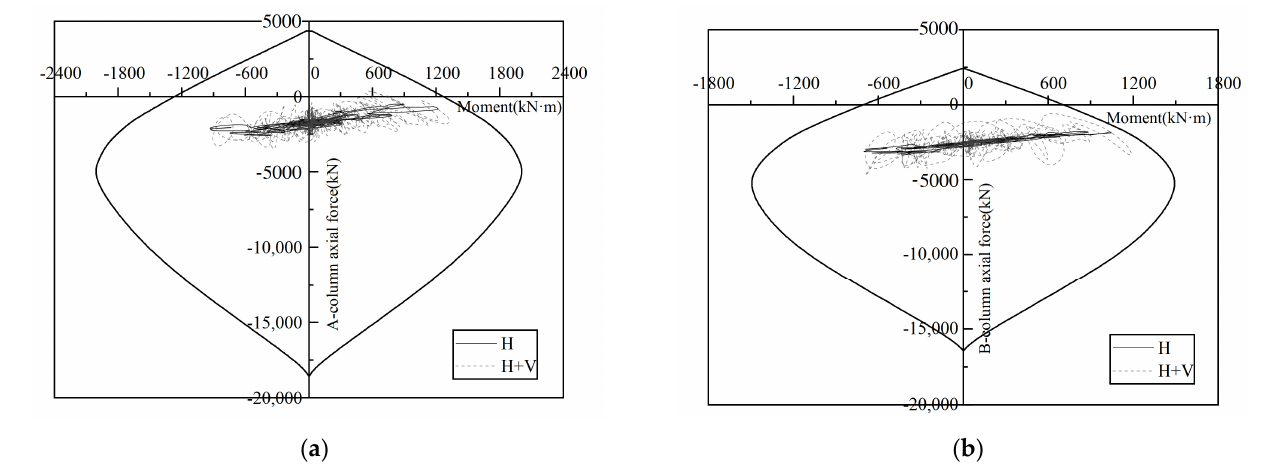
9 of 19 Figure 6. Time − history curve of A and B − column axial force under two conditions of Yangbi ground motion. The following part analyzes the interaction between axial force and a bending mo ‐ ment of the A ‐ column and B ‐ column is analyzed. The variation curves of the axial force